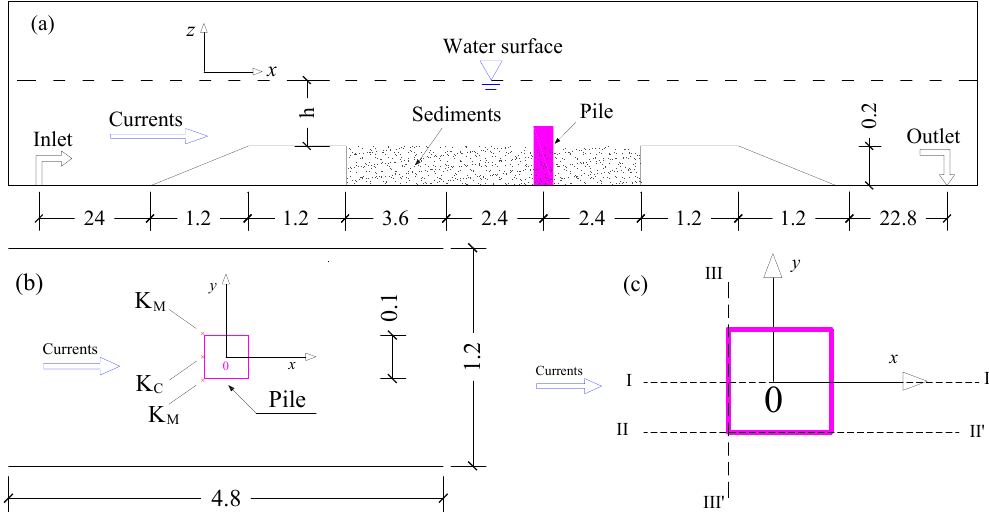
Figure 1. A brief view of the test flume. ( a ) Side view of the flume; ( b ) Top view of the test section; ( c ) Definitions of the profiles.